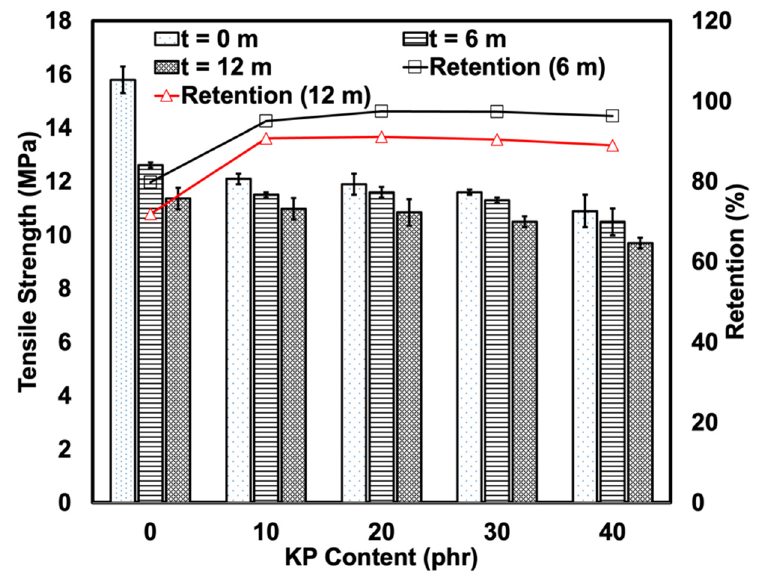
Figure 5. Tensile strength and retention of KP-filled rHDPE/NR blends before and after 6 and 12 months of natural